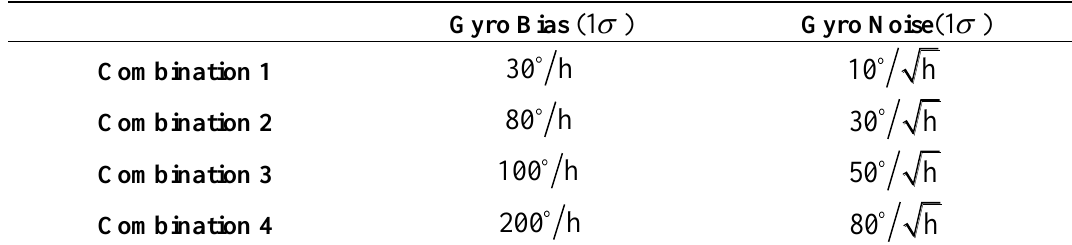
Table 4. The simulation parameters of MEMS